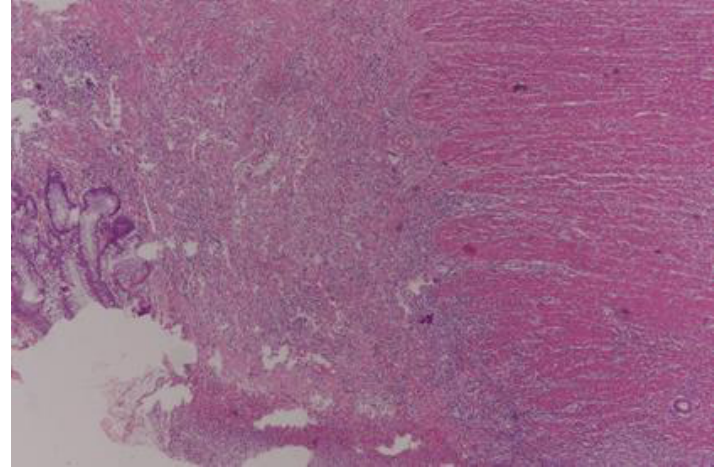
Figure 1. Complete pathologic response (TRG0); x 40 HE; Mucosal ulcer area, no residual tumor.